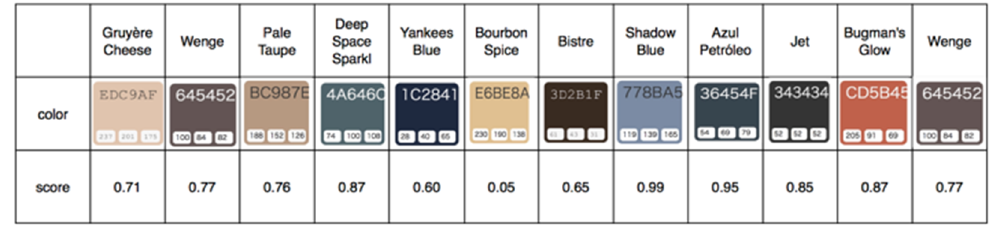
Figure 12. Example of color name Score (cid:2913)(cid:2925)(cid:2922)(cid:2925)(cid:2928) (cid:2924)(cid:2911)(cid:2923)(cid:2915) (x (cid:2919) ) .